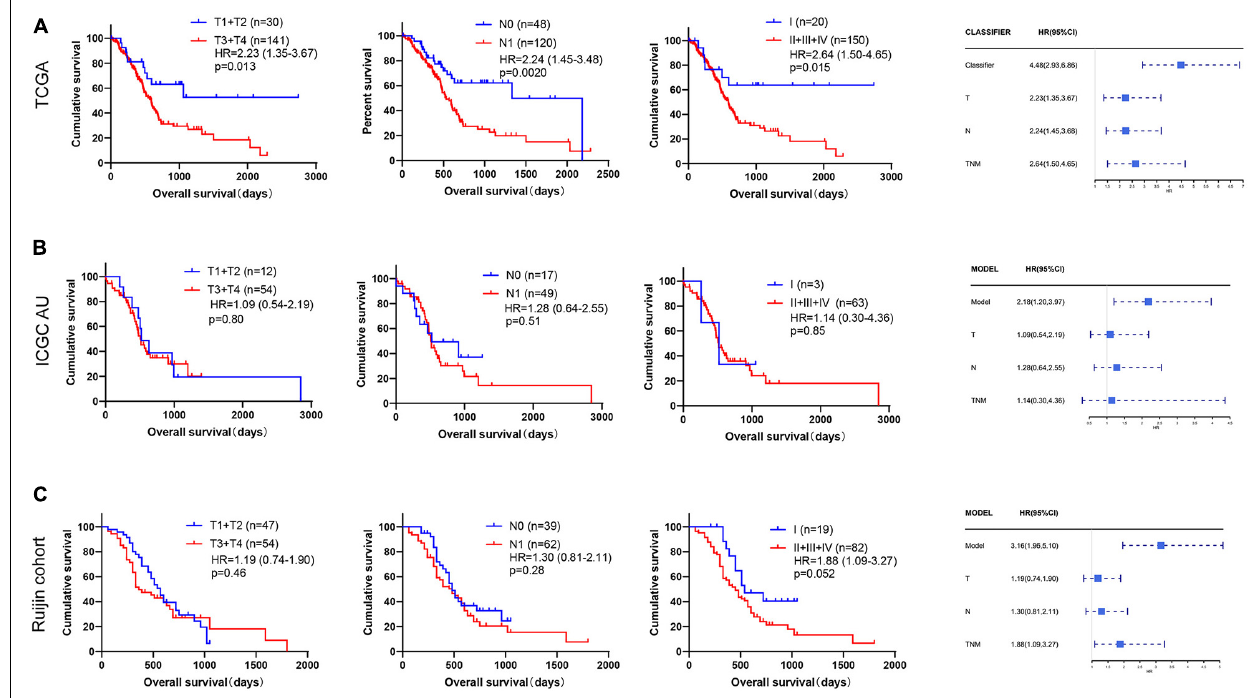
FIGURE 4 | Comparison of prognostic prediction ability between our immune signature and TNM stage. The Kaplan-Meier survival curves according to TNM stage, and forest plots show the HR value of our immune signature and TNM stage in (A) TCGA ( n = 173), (B) ICGC AU ( n = 68), and (C) Ruijin cohort ( n = 101).